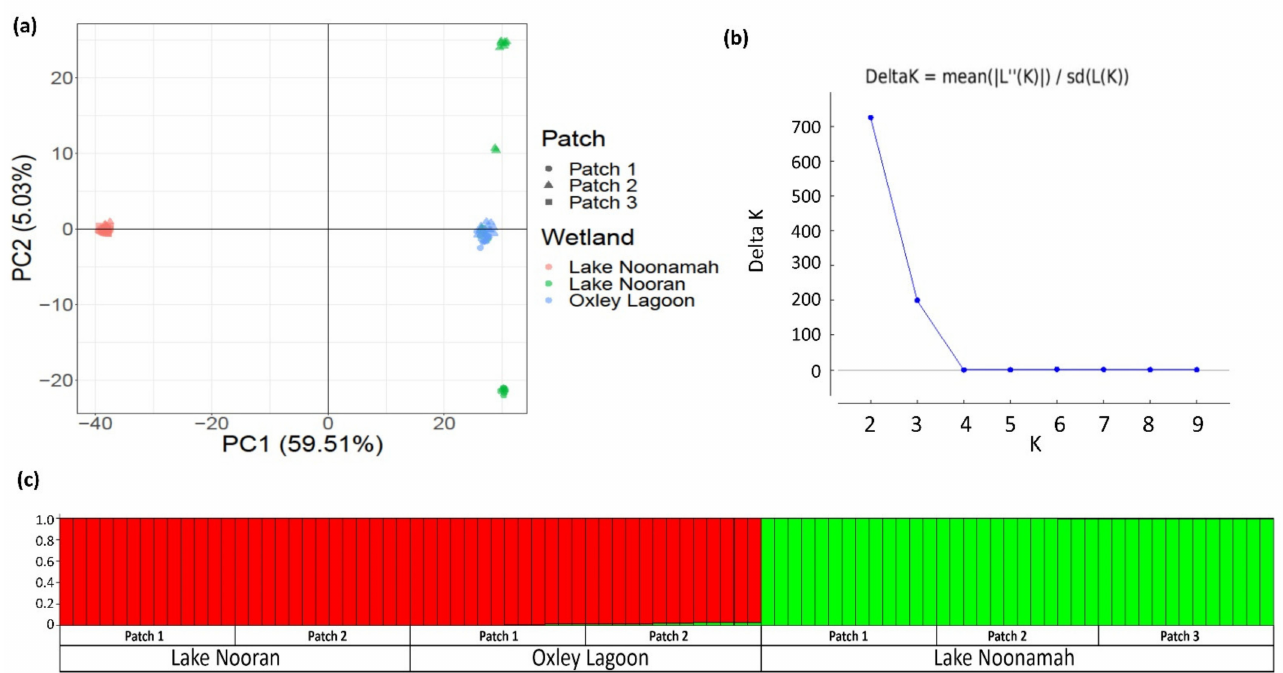
Figure 4. ( a ) Plot from PCoA analysis of 86 E. acuta genotypes across three wetlands (2–3 patches per wetland) in the lower Lachlan River Catchment; ( b ) representation of the Akaike value used to determine the number of populations (K); and ( c ) representation of the probability of population assignment with each individual genotype, coloured by cluster and ordered by wetland and